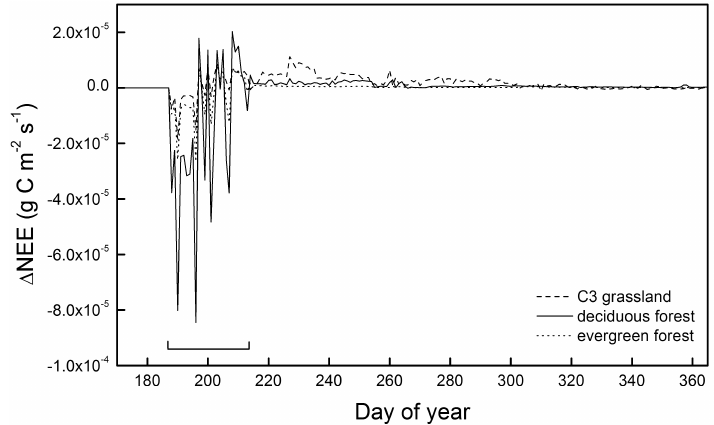
Fig. 4. Yearly course of net ecosystem exchange for three different plant functional types modeled with ORCHIDEE: differences between “natural drought” and “precipitation only drought” for the modelling experiment using the meteorological data of the Vielsalm site. Drought period (day 188–213)